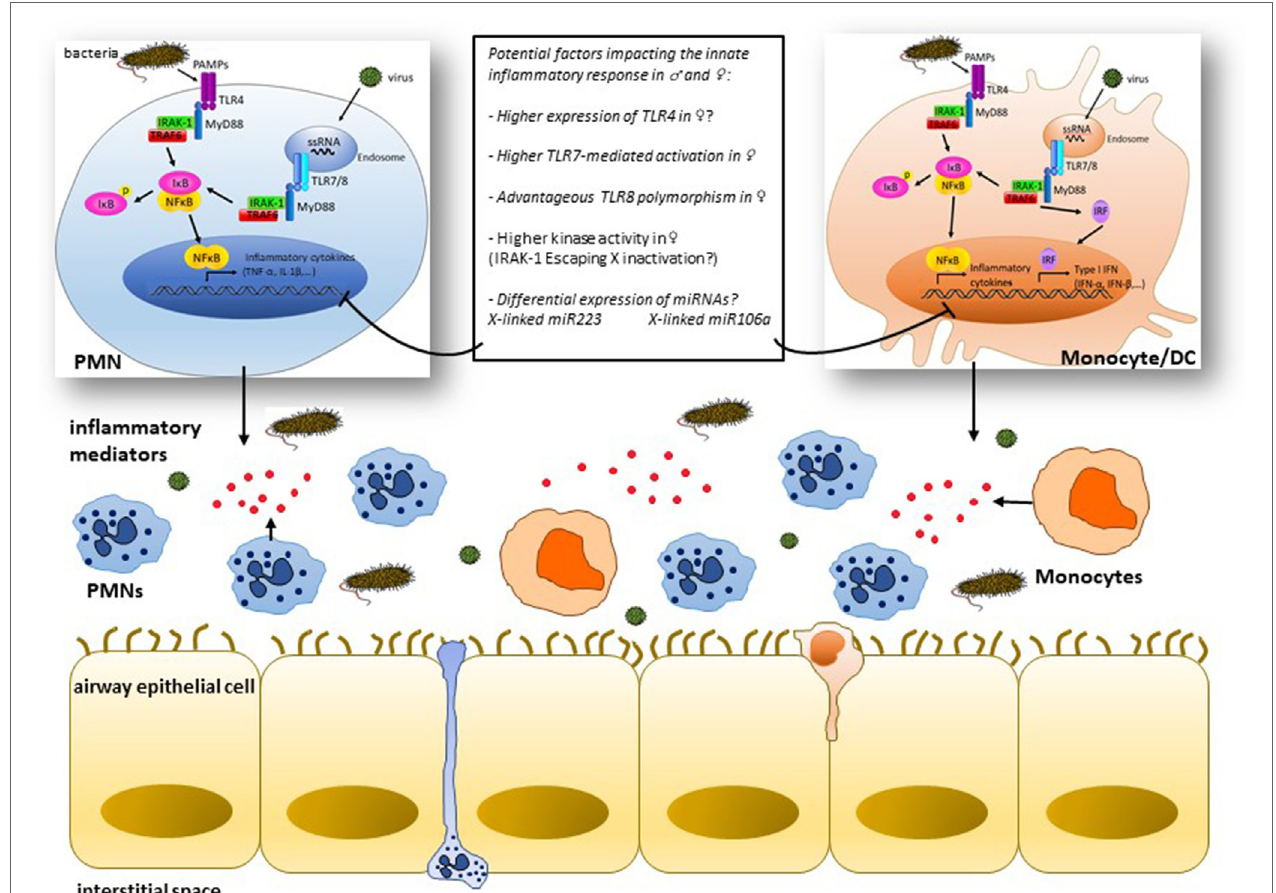
FiGURe 1 | Simplified view of some mechanisms of cell type-specific signaling downstream of toll-like receptors (TLRs) potentially implicated in the sex bias of infection-induced airway inflammation: pathogen-associated molecular patterns (PAMPs) like lipopolysaccharides and single-strand RNA (ssRNA) interact with innate cells, i.e., polymorphonuclear (PMNs) cells and monocytes/dendritic cells through surface expressed TLR4 or endosomal TLR7/8, respectively, leading to the recruitment of adaptor molecules like MyD88 and activation of IL-1 receptor-associated kinase-1 (IRAK-1) among other kinases that culminate through TNF receptor-associated factors (TRAFs) with the activation of the transcription factors NF- κ B and interferon regulatory factors (IRFs) and subsequent production of the inflammatory mediators (TNF- α , IL-1 β , etc.) and type I interferon (IFN) gene products. Differences in the expression and/or activation of one of the cascade signaling partners between males and females may result in distinct inflammatory responses. Innate genes lying on the X chromosome, e.g., IRAK-1, likely influence the magnitude of the inflammatory response in females through a potent escape from X inactivation process. X chromosome-linked miR223 and miR106a are potentially key miRNAs that may contribute to the contrasting outcome of the inflammatory response in males and females by regulating the innate immune signaling in PMNs and monocytes,